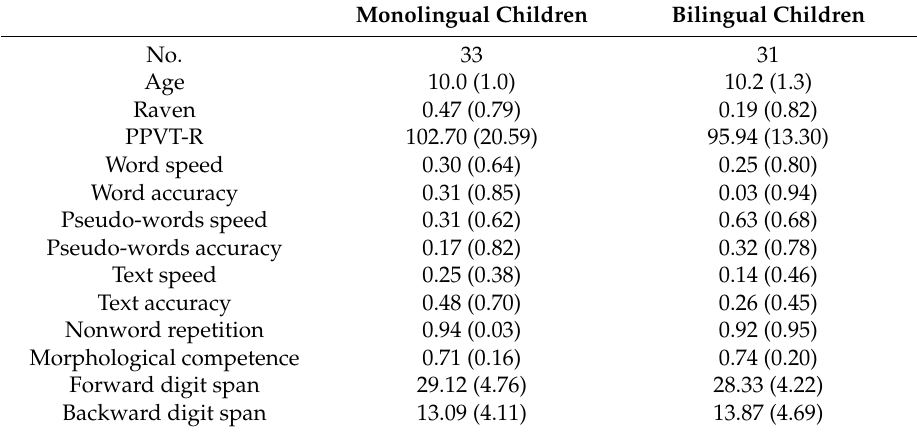
Table 2. Number, mean (SD) age in years, means (SDs) of z scores on the Raven, on the speed and accuracy of reading words, pseudo-word and text, mean (SDs) of raw scores of the PPVT-R, of the nonword repetition task, on the morphological competence task (nonword pluralization), and on the working memory (WM) tasks (forward and backward digit span